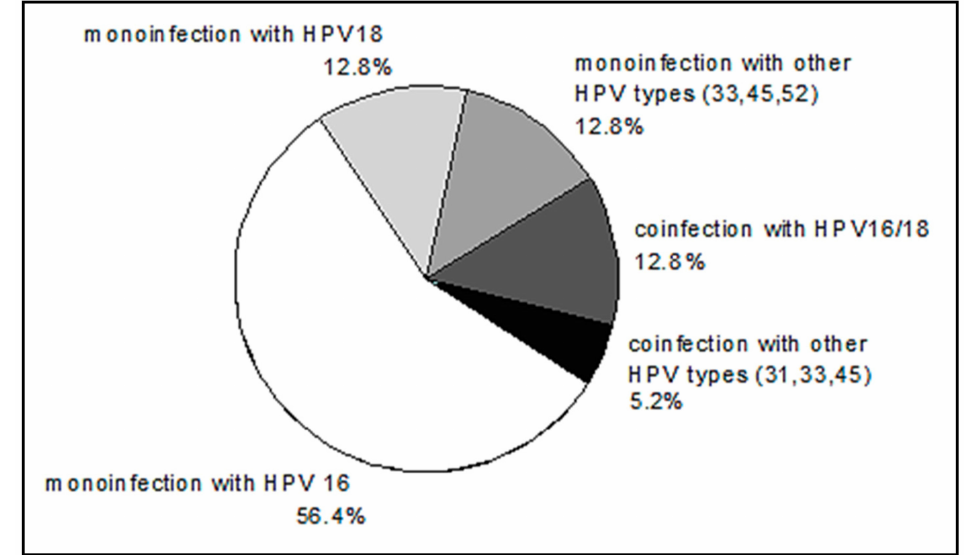
Figure 5. The distribution of human papillomavirus (HPV) genotypes in CC